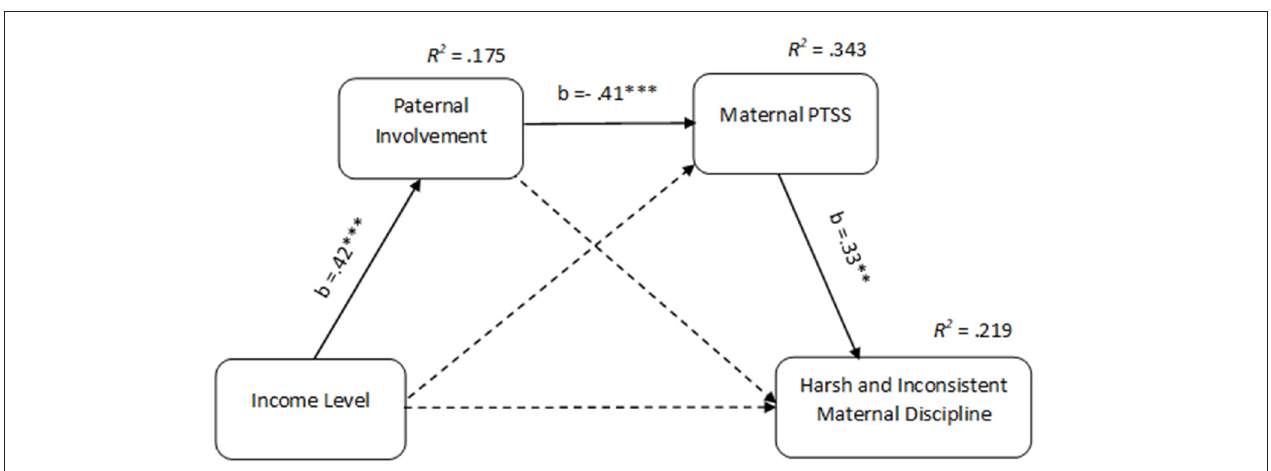
FIGURE 1 | Serial mediation model for the effect of family income on harsh and inconsistent maternal discipline via paternal involvement and PTSS of mothers coping with breast cancer. PTSS, Post Traumatic Stress Symptoms. Control variables: cancer stage and time since diagnosis. Entries are standardized structural coefficients. Dashed paths were not found to be significant. ** p < 0.01. *** p <